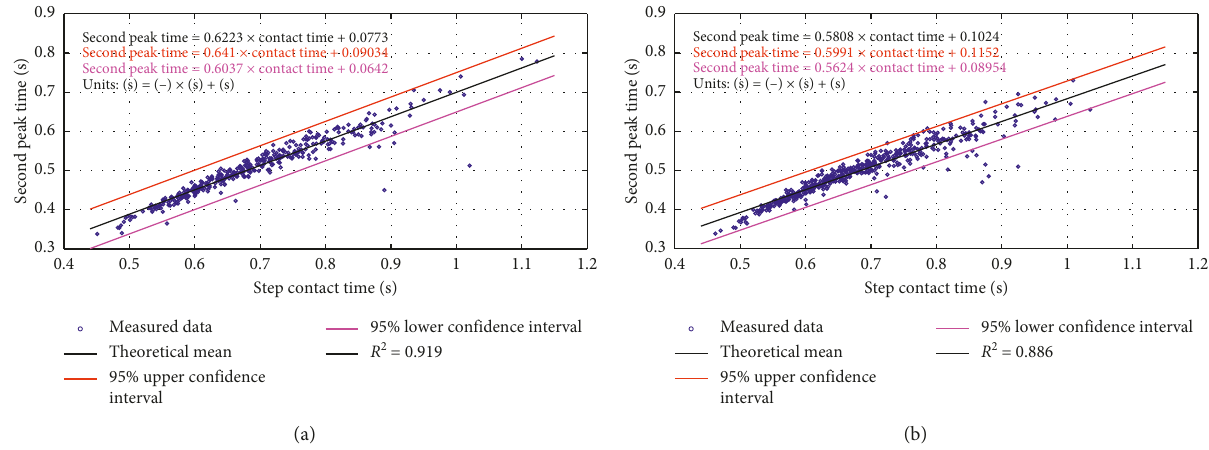
Figure 6: Statistical relationship between step contact time and second peak time. (a) Right footfall; (b) left